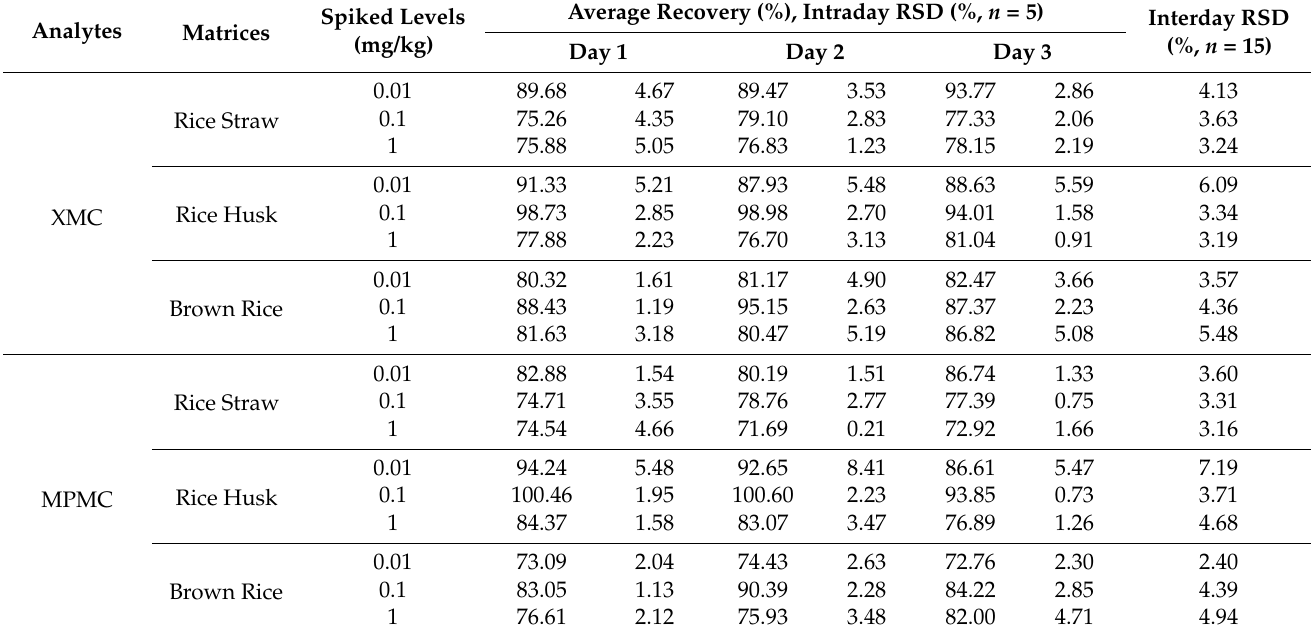
Table 2. Recoveries and RSDs for dimethacarb in